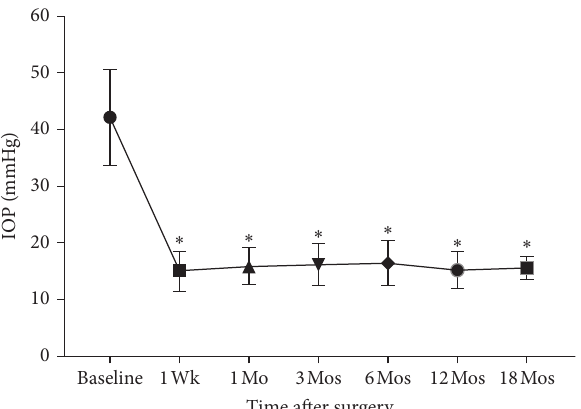
Figure 2: Change in IOP throughout the study period. Compared with baseline, the IOP (mean ± SD) was significantly decreased at all time points after the combined surgery ( ∗ P < 0 . 0001).